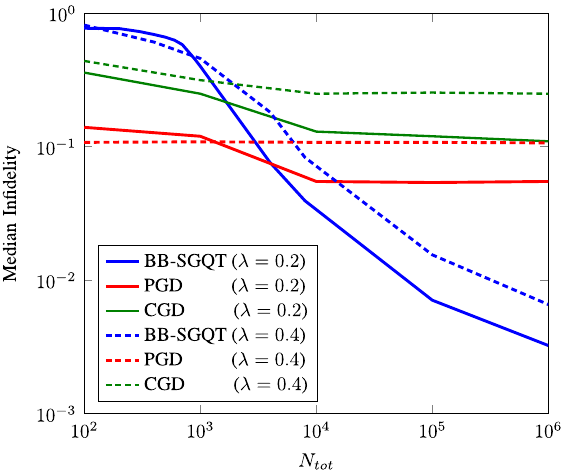
Figure 4. Average infidelity plots for d = 4 with 20% and 40% depolarizing noise (solid and dashed) are plotted against total resources N tot by taking the average for 100 randomly generated qubits using Haar measurements. Blue, red and green represent BB-SGQT, PGD and CGD respectively.